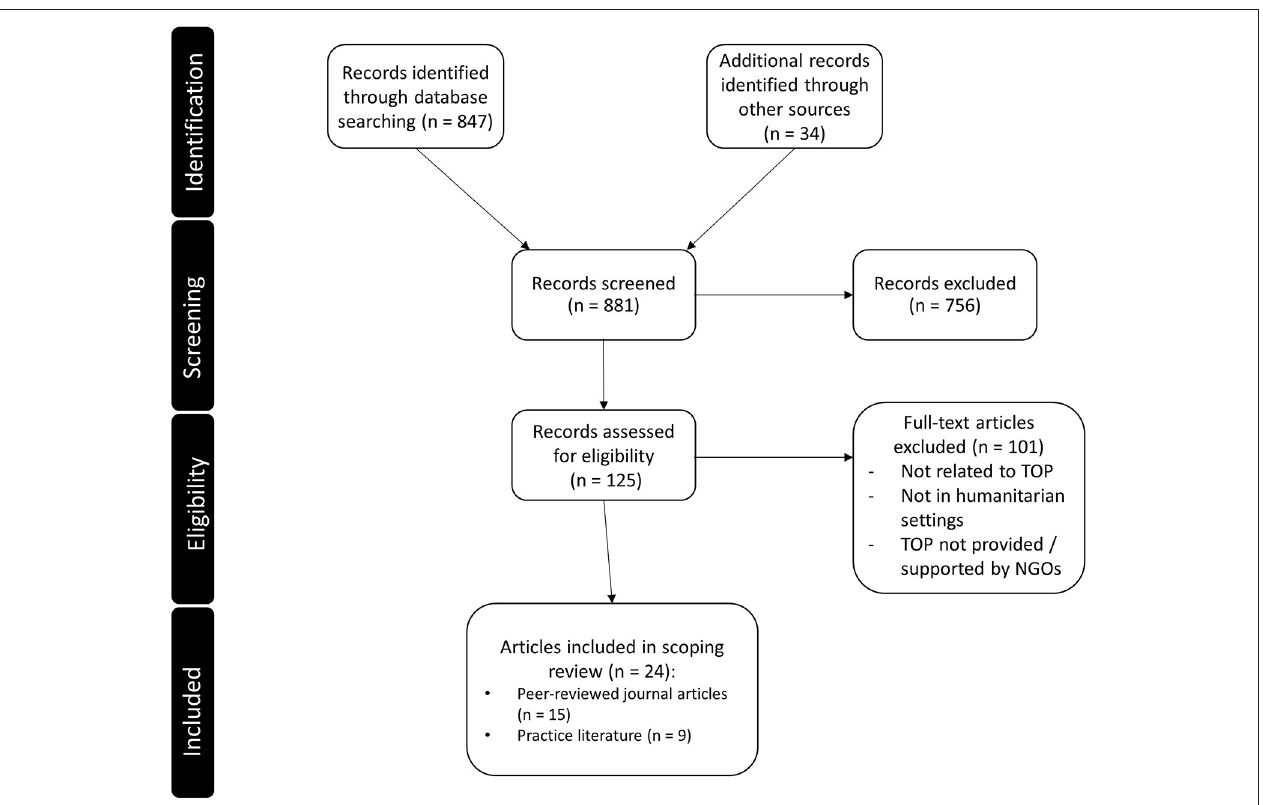
FIGURE 1 | PRISMA